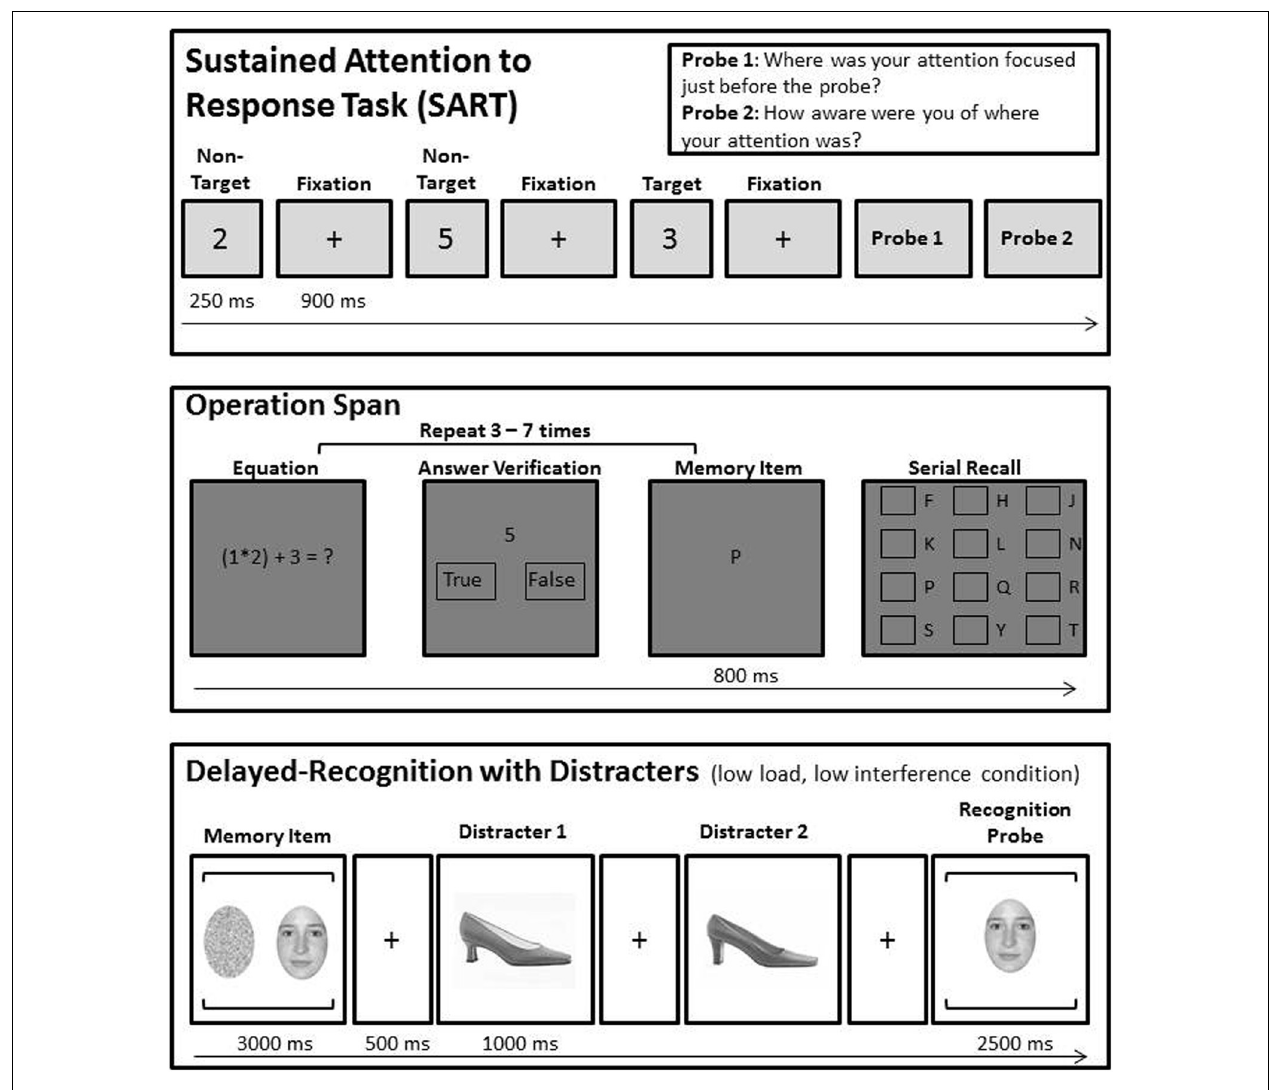
awareness. Participants responded on a Likert scale. In the operation span task, trials presented interleaved letters and math problems, and after each sequence, participants reported the letters in serial order. During the delayed recognition task participants were presented one or two memory items (faces or shoes), and after a series of two distracters, were asked whether a probe was an identical match to the memory